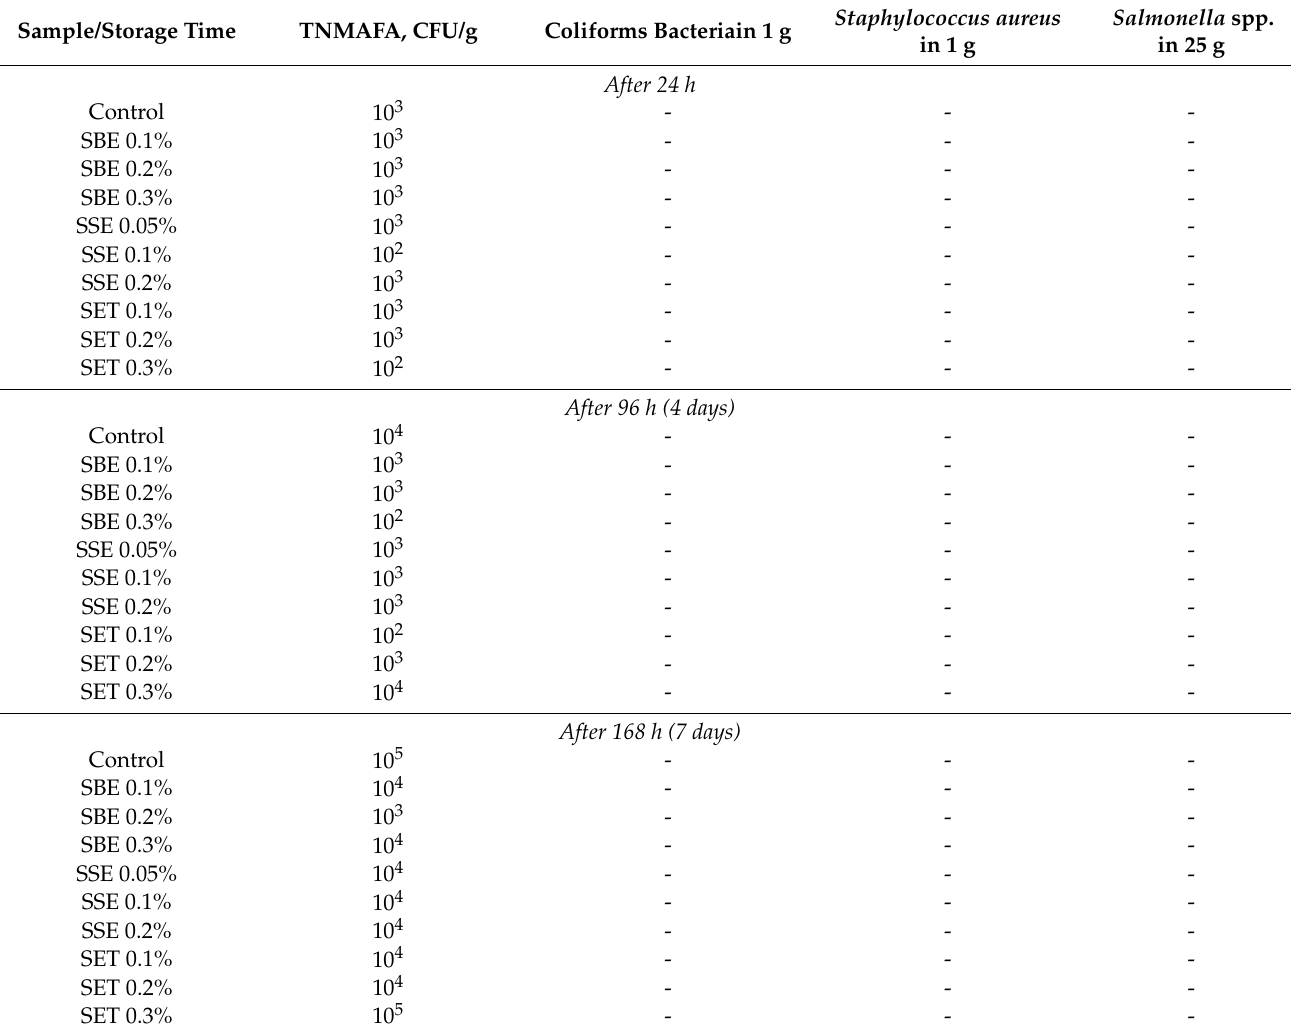
Table 3. The identified microorganisms after a period of time since the manufacture of